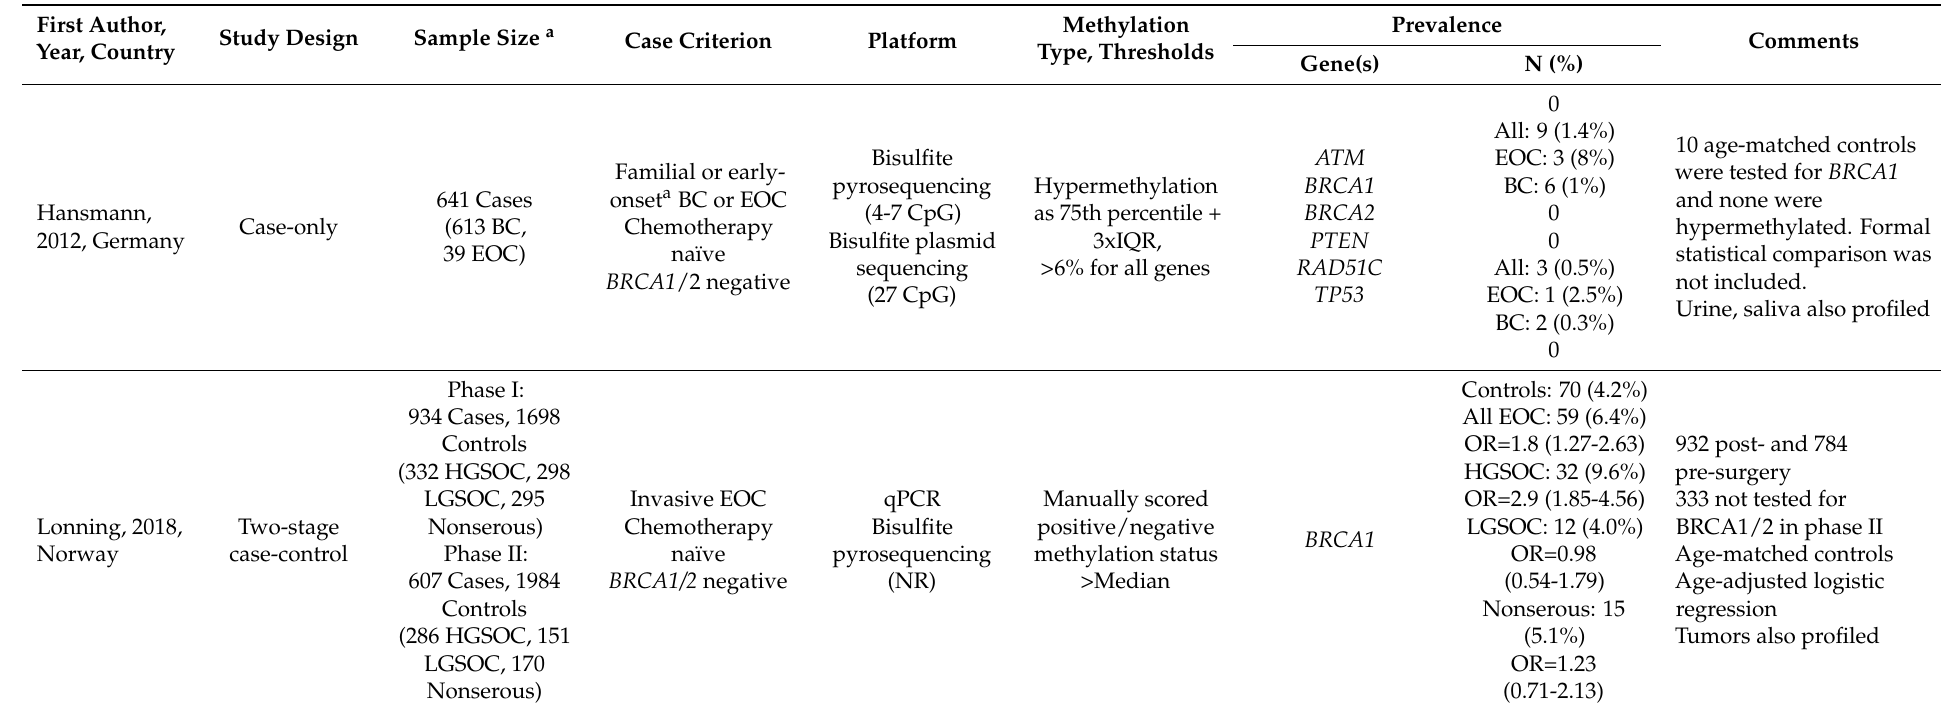
Table 1. DNA methylation in known ovarian cancer susceptibility